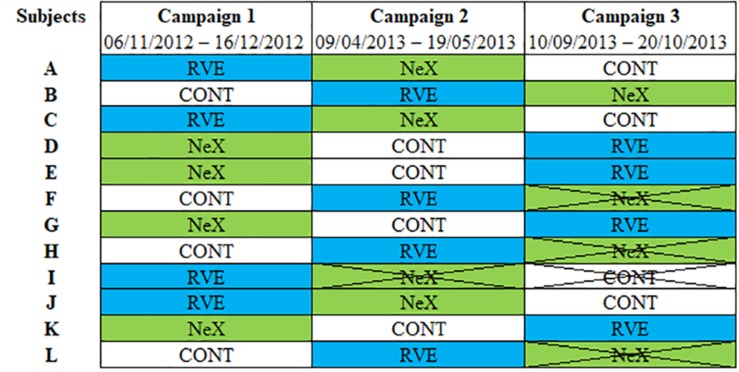
The different allocations for each subject with the exact dates of sessions. CON, control condition; NeX, resistance vibration exercise with nutritional supplementation condition; RVE, resistance vibration exercise condition.